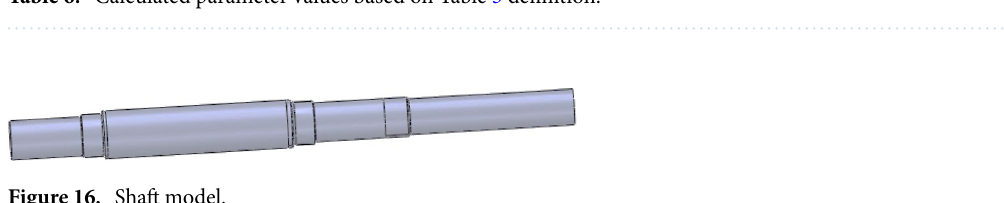
Figure 16. Shaft